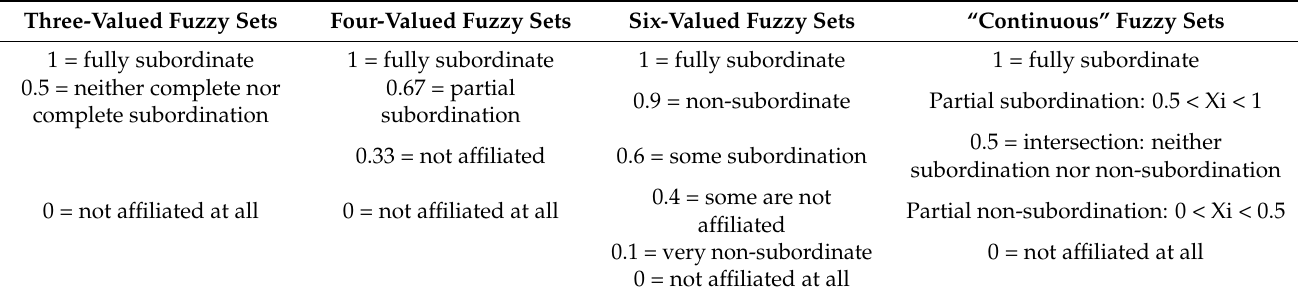
Table 3. Classification of fuzzy sets (data source: reference [37]). Three-Valued Fuzzy Sets Four-Valued Fuzzy Sets Six-Valued Fuzzy Sets “Continuous” Fuzzy